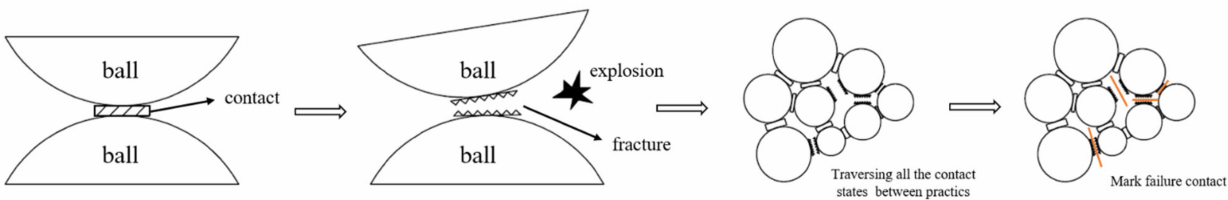
Figure 11. Schematic diagram of damage display